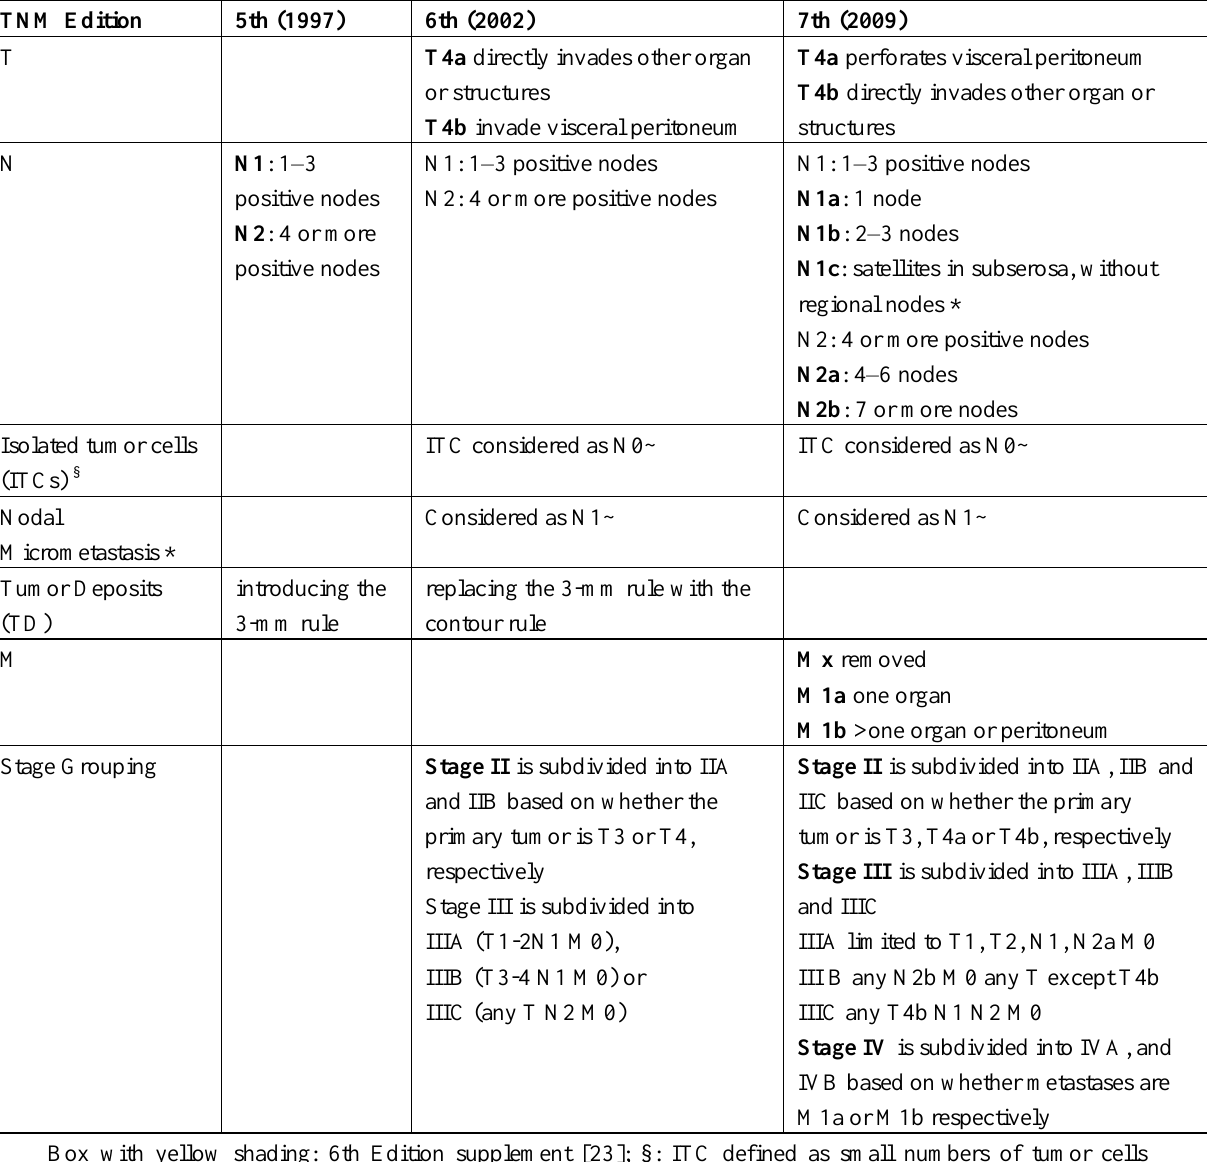
Table 2. Comparison of the last three editions of TNM